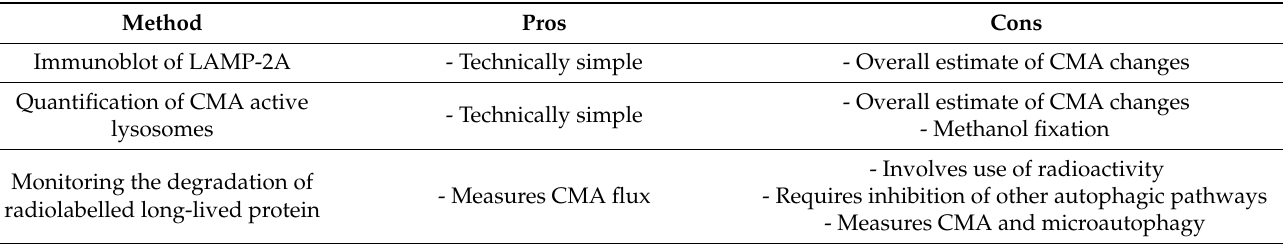
Table 1. Pros and cons of the different methods used to monitor